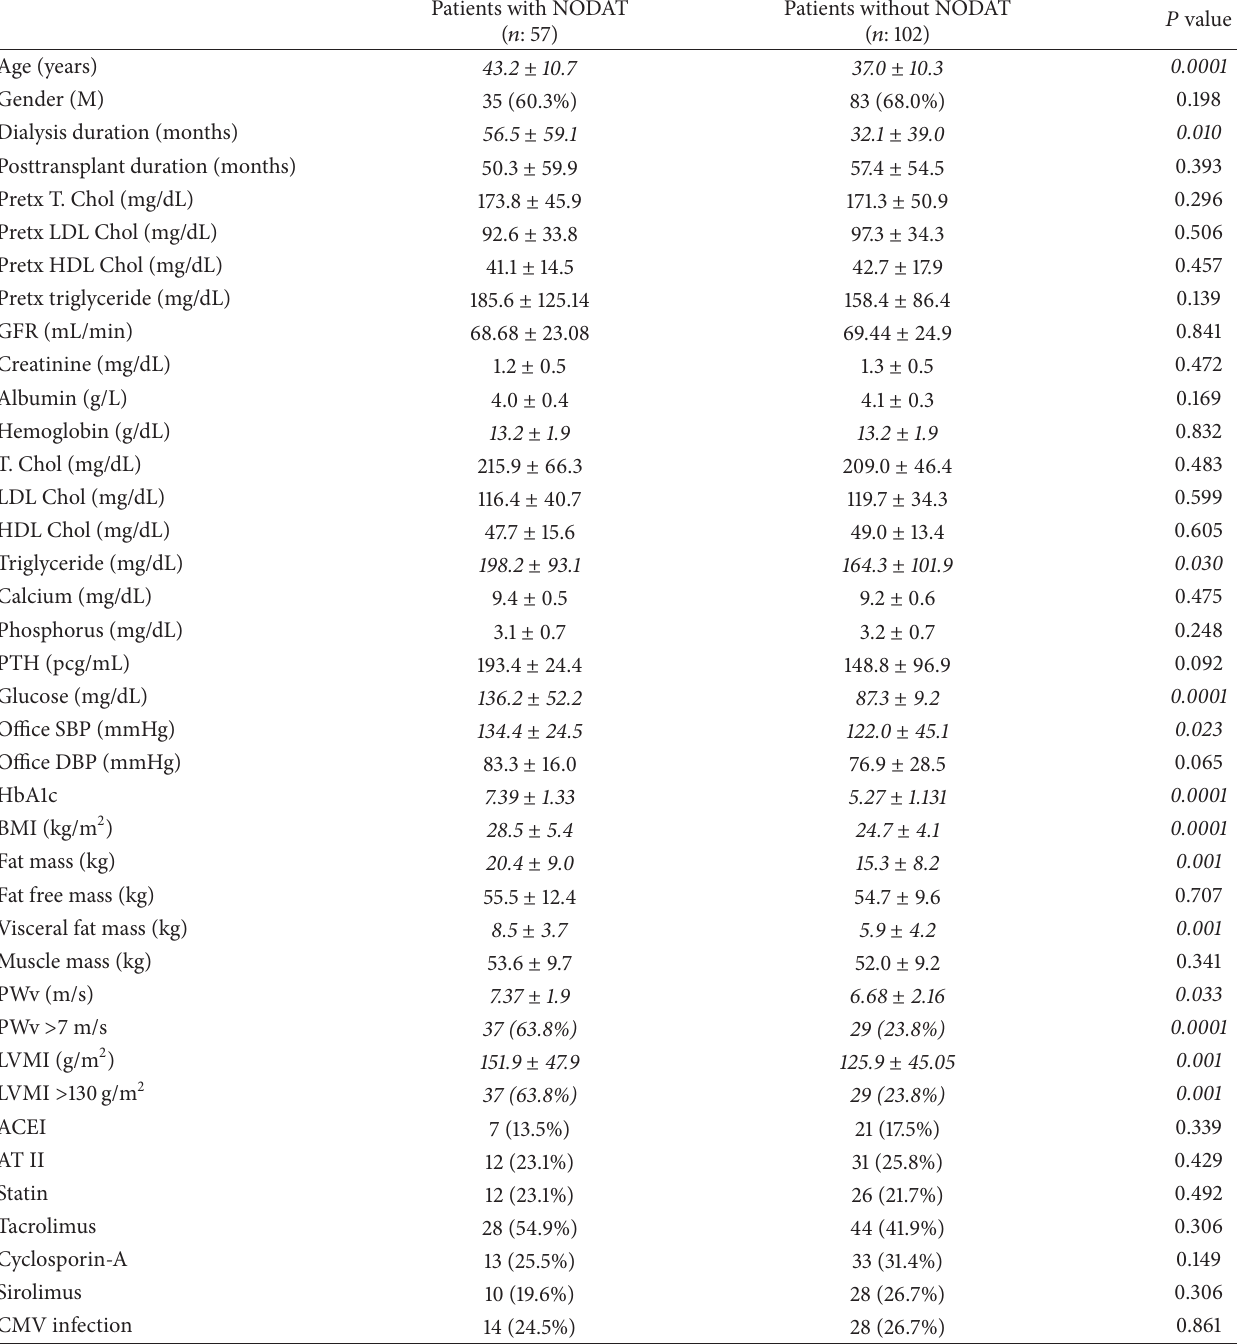
Table 1: The clinical and biochemical parameters of patients according to NODAT groups. Patients with